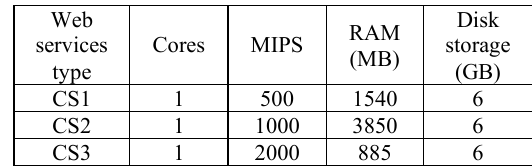
Table 1. Simulation environment and parameter